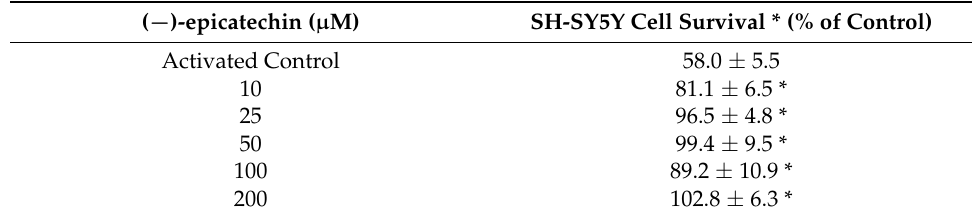
Table 2. Protective effect of ( − )-epicatechin against 6-OHDA cytotoxicity in SH-SY5Y cells. SH-SY5Y cells were exposed to 6-OHDA (150 µ M) in the presence of increasing concentrations of ( − )-epicatechin (from 10 to 200 µ M). The results are expressed as percentage of non-treated control and are represented by mean ± SD ( n = 3). * p < 0.05 compared to the control activated. Activated control were treated with only 6-OHDA (150 µ